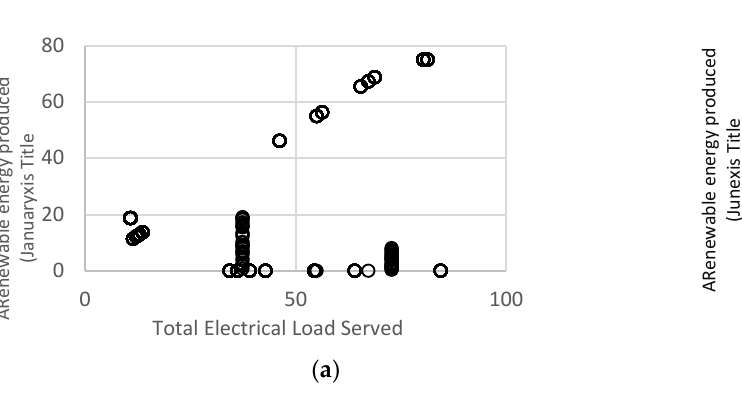
Figure 15. Renewable penetration values (%) scored in January ( a ) and June ( b ).